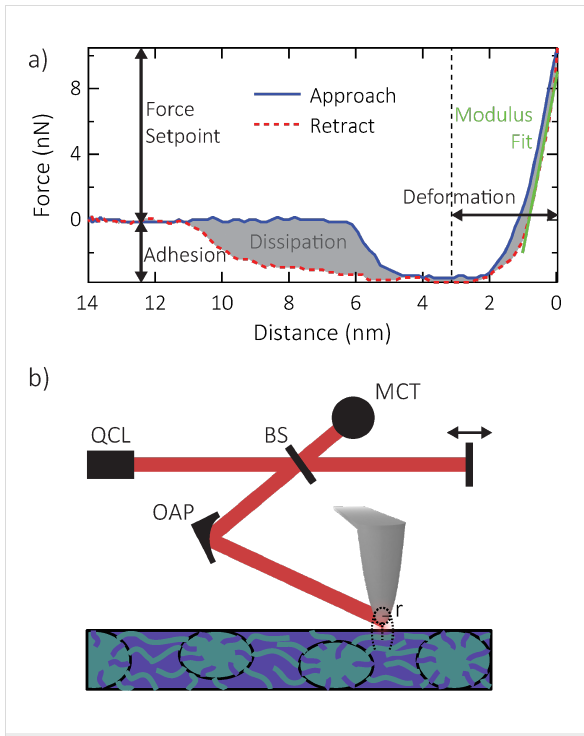
Figure 1: (a) Example force–distance curve from a single force volume at a given force setpoint, showing the properties that are analyzed to create maps of modulus, adhesion, deformation, and dissipation. (b) Schematic of s -SNOM setup, showing the quantum cascade laser (QCL), beam splitter (BS), off-axis parabolic (OAP) mirror, mercury–cadmium–telluride (MCT) detector, moving reference arm mirror, and tip–sample interaction confined to the tip radius r . Sample feature size exaggerated for visual